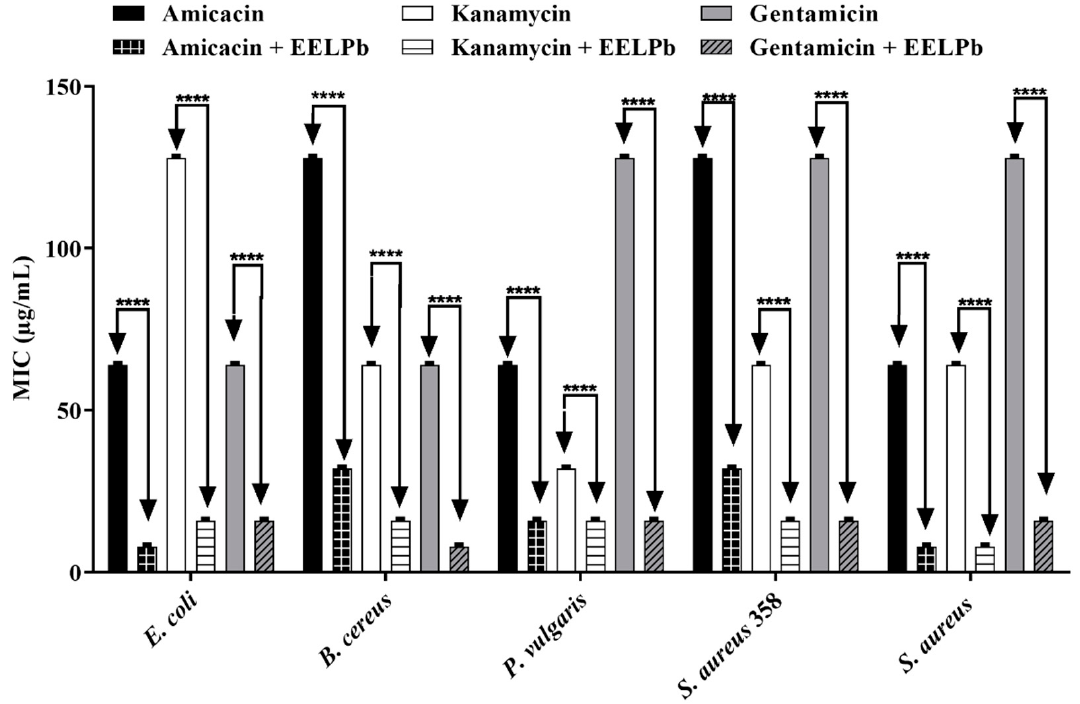
Figure 3. Modulatory effect of P. barbatus fresh leaf ethanol extract on the antibiotic activity of amikacin, kanamycin and gentamicin against E. coli , B. cereus , P. vulgaris , S. aureus 358 and S. aureus strains. ****: p < 0.0001 (ANOVA and Tukey’s test).